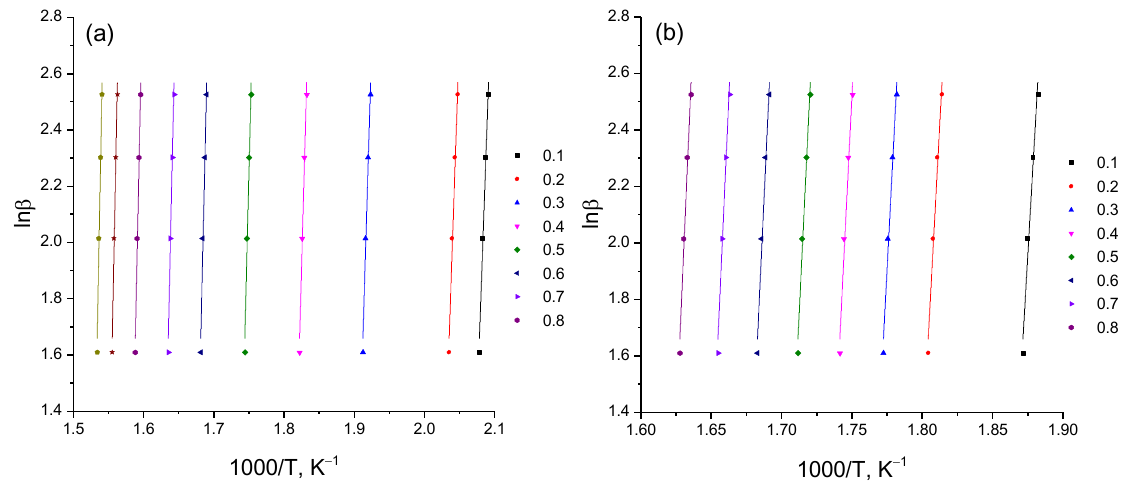
Figure 11. Logarithmic dependence of ln β on 1/T, constructed according to thermogravimetric analysis ( a ) β -CD–resveratrol (2:1) and ( b ) β -CD–resveratrol (4:1) (Flynn–Ozawa–Wall method) at heating rates from 5 to 12.5 ◦ C/min.